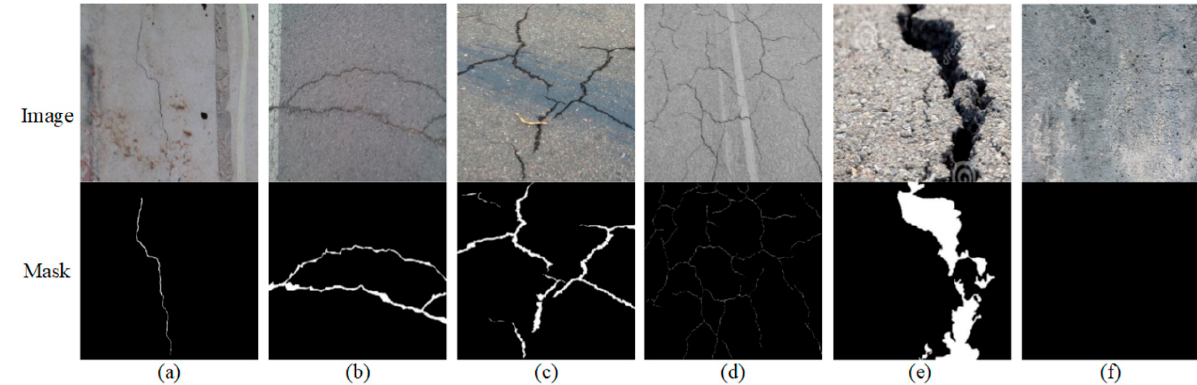
Figure 4. Representative samples in the dataset. ( a ) Is a single crack in a complex environment, ( b ) is a compound crack in a simple environment, ( c ) is a crack taken at an oblique angle, ( d ) is a net-like crack, ( e ) is a coarse crack taken at close range, and ( f ) is an image without cracks.